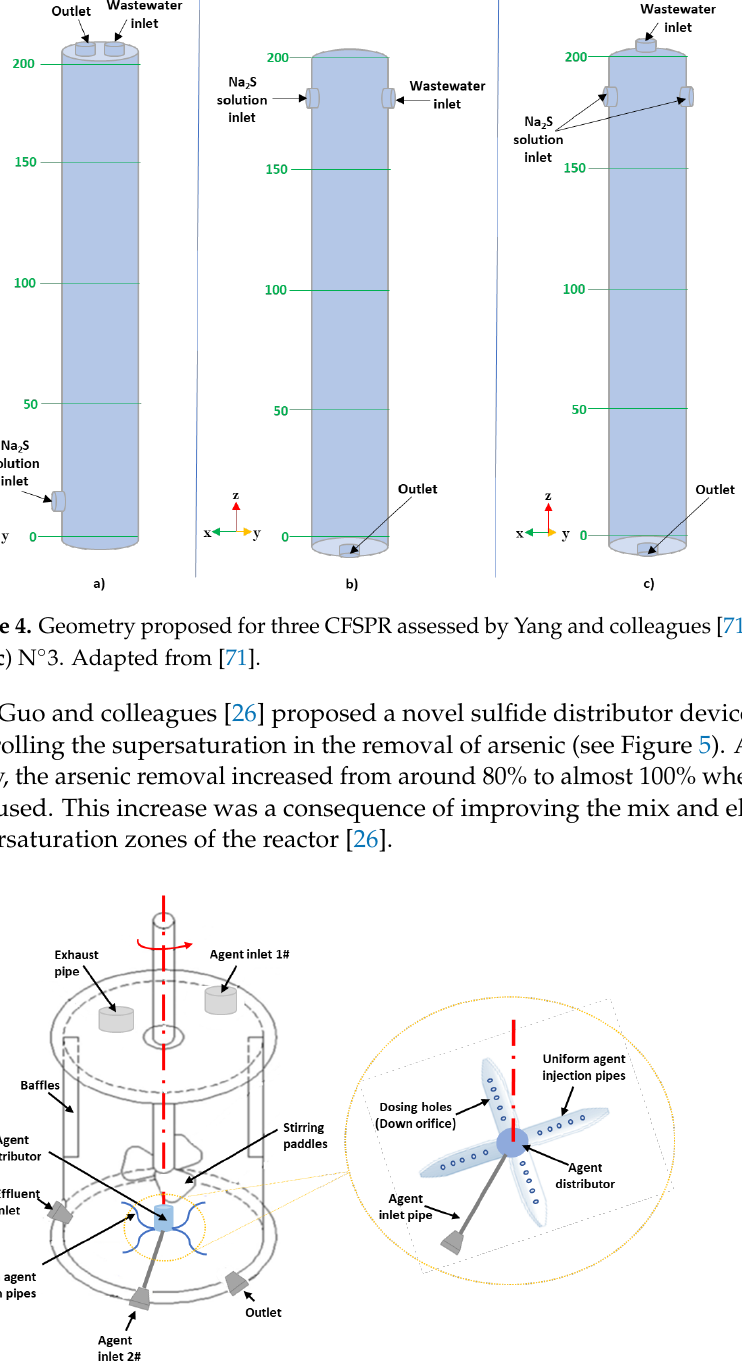
Figure 5. Sulfide distributor device proposed by Guo and colleagues [26] to control the supersaturation. Adapted from [26].